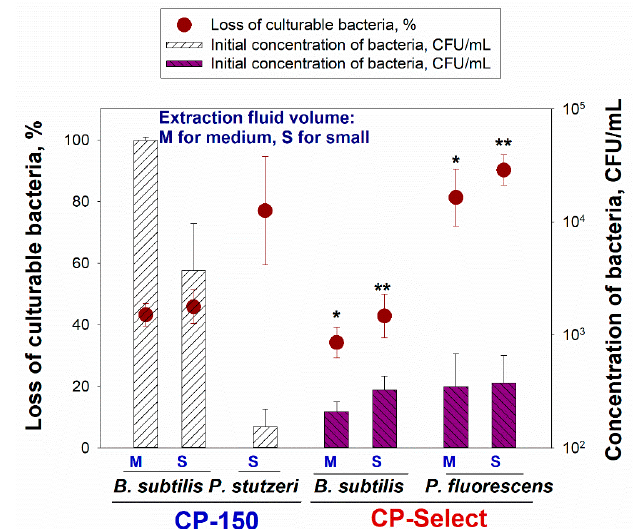
Figure 5. Losses (%) of culturable bacteria when using the CP ‐ 150 and the CP ‐ Select with different elution fluid volumes (M: Medium and S: Small) as determined by the culture ‐ based analysis. The data represent the averages of three repeated measurements, and the error bars represent one standard deviation. The extent of losses was compared using ANOVA, and p ‐ values are based on multiple pairwise comparisons using the Holm–Sidak method. * indicates a significant difference ( p < 0.05) for the loss of culturable bacteria at the M volume setting between B. subtilis and P. fluorescens . ** indicates a significant difference ( p < 0.001) for the loss of culturable bacteria at the S volume setting between B. subtilis and P. fluorescens . One elution was used for CP ‐ 150 at the M setting, and three elutions were used for all the other settings.